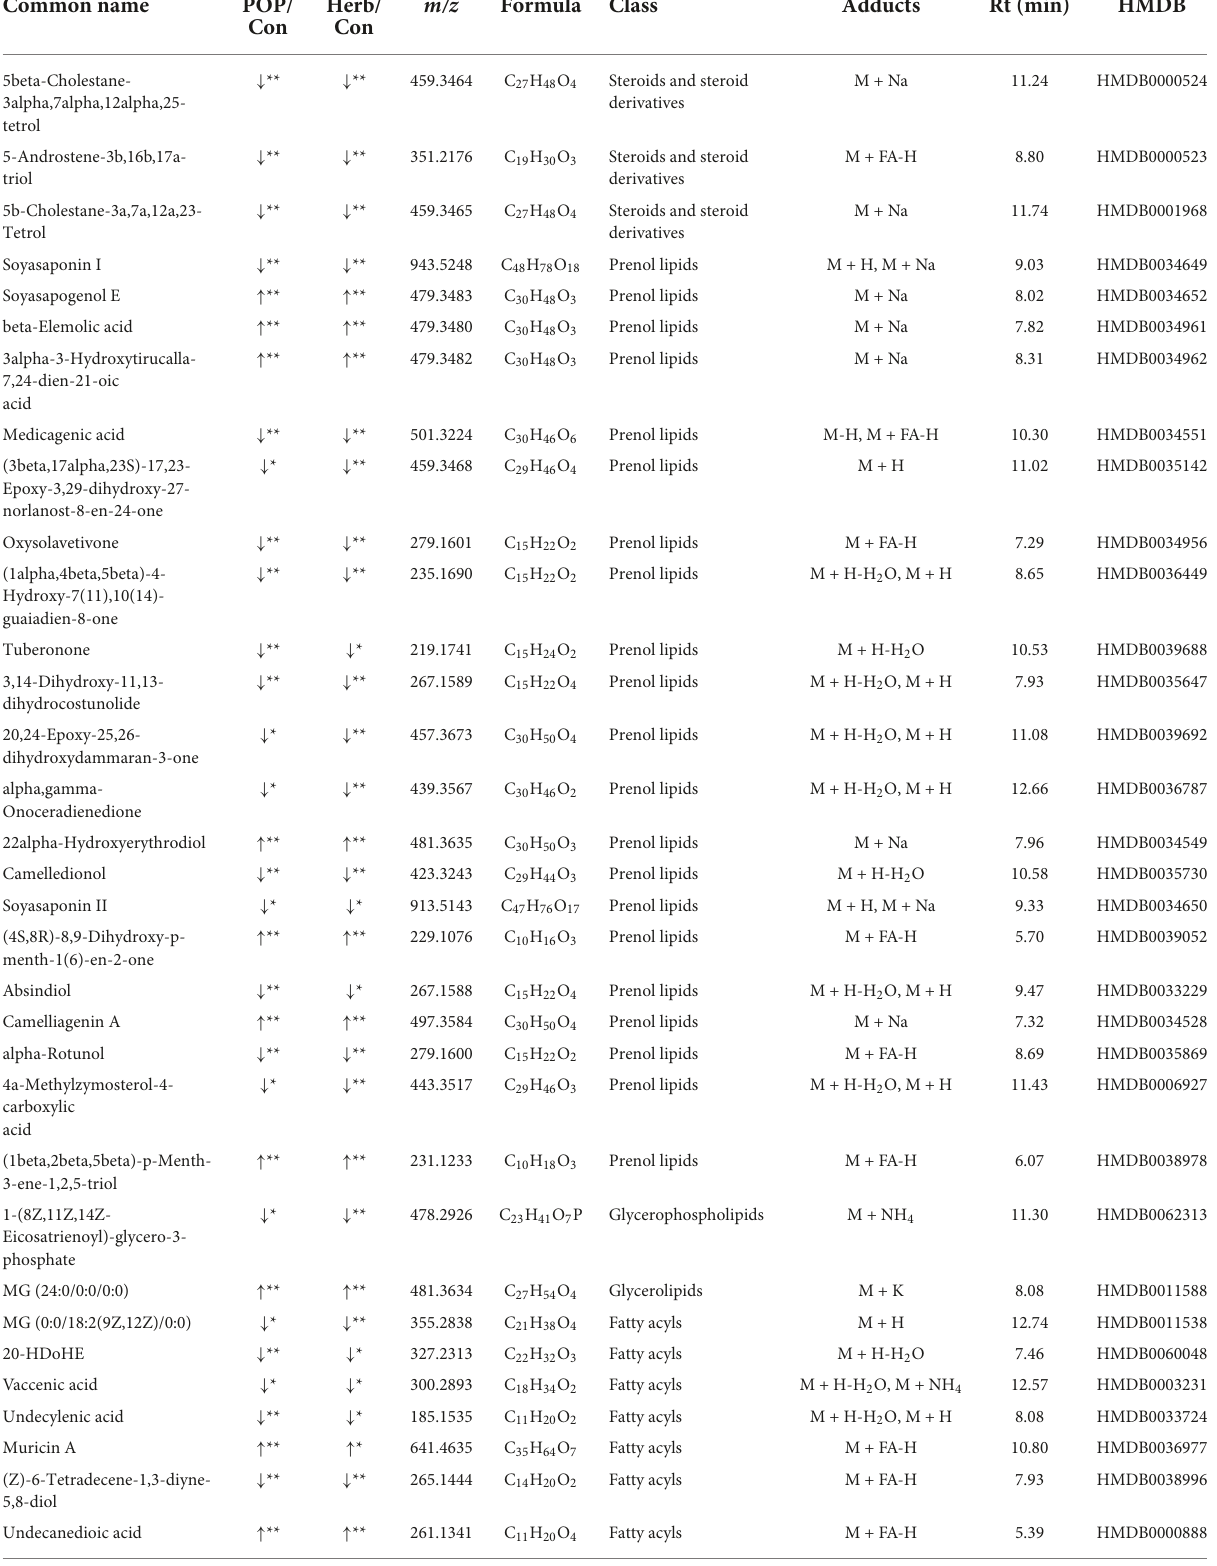
TABLE 2 The 33 kinds of lipid and lipid molecular metabolites that significantly influenced by purslane polysaccharides in aging